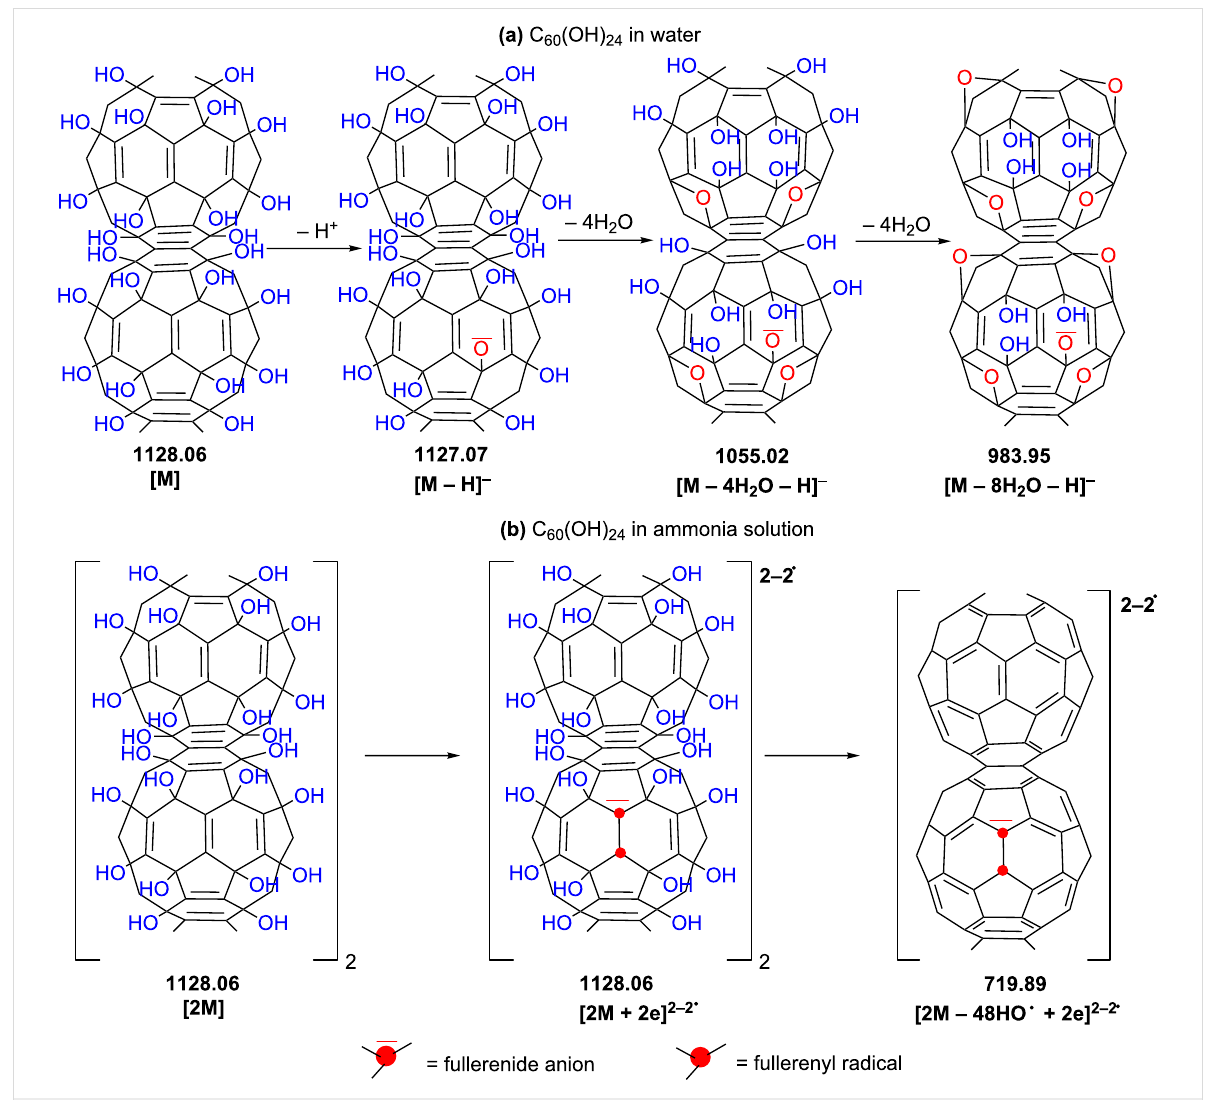
Scheme 2: Examples of proposed structures for the main deprotonated molecules and final distonic molecular ion observed by ( − )ESI-MS of C 60 (OH) 24 in pure water (a) and aqueous ammonia solution